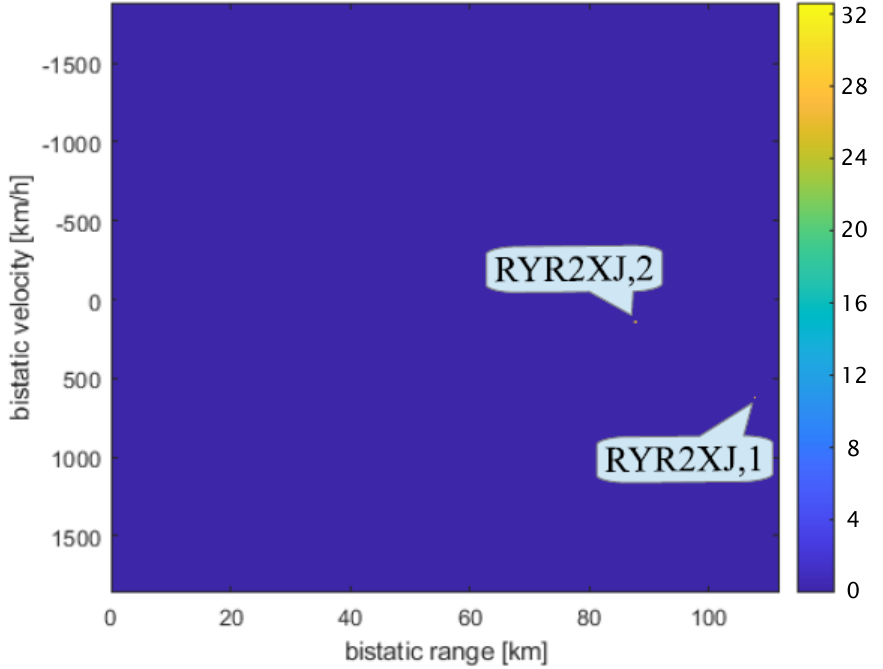
Figure 23. Cross-ambiguity function for the beam steered in the direction of the RYR2XJ plane.